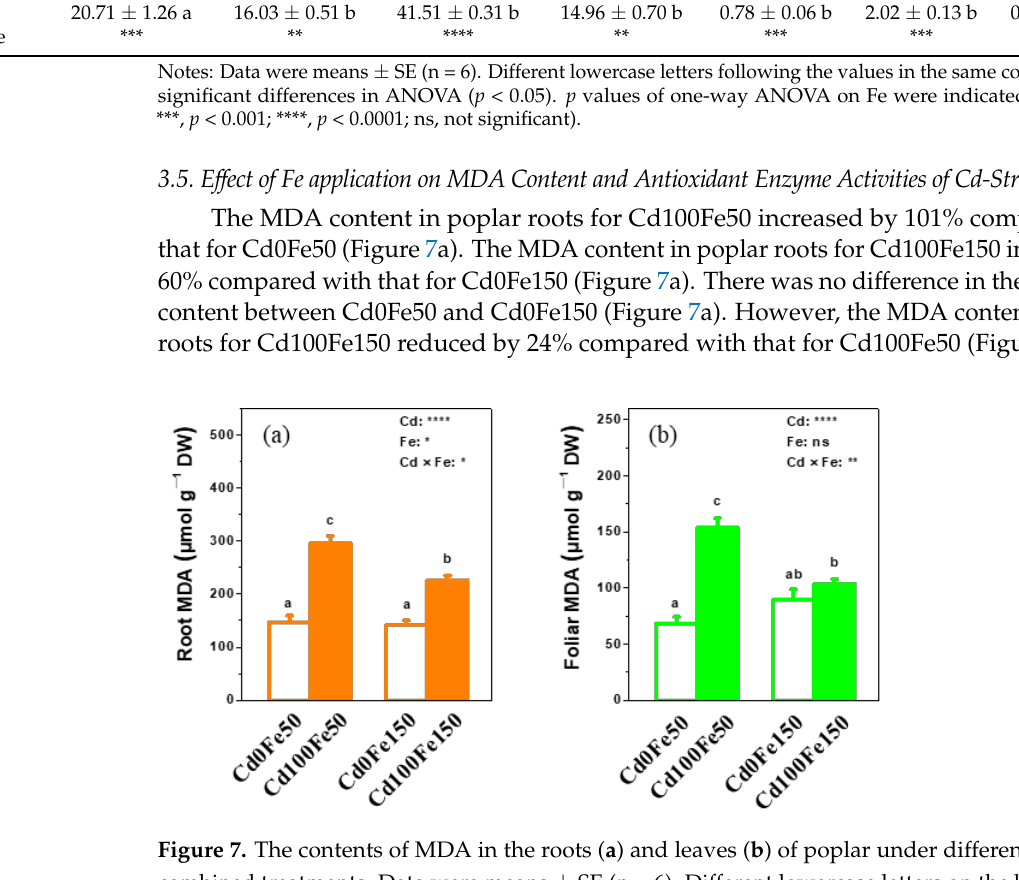
Table 1. BAF, BCF, and TF for Cd in the roots (R), woods (W), barks (B), and leaves (L) of poplar under different Cd and Fe combined treatments.